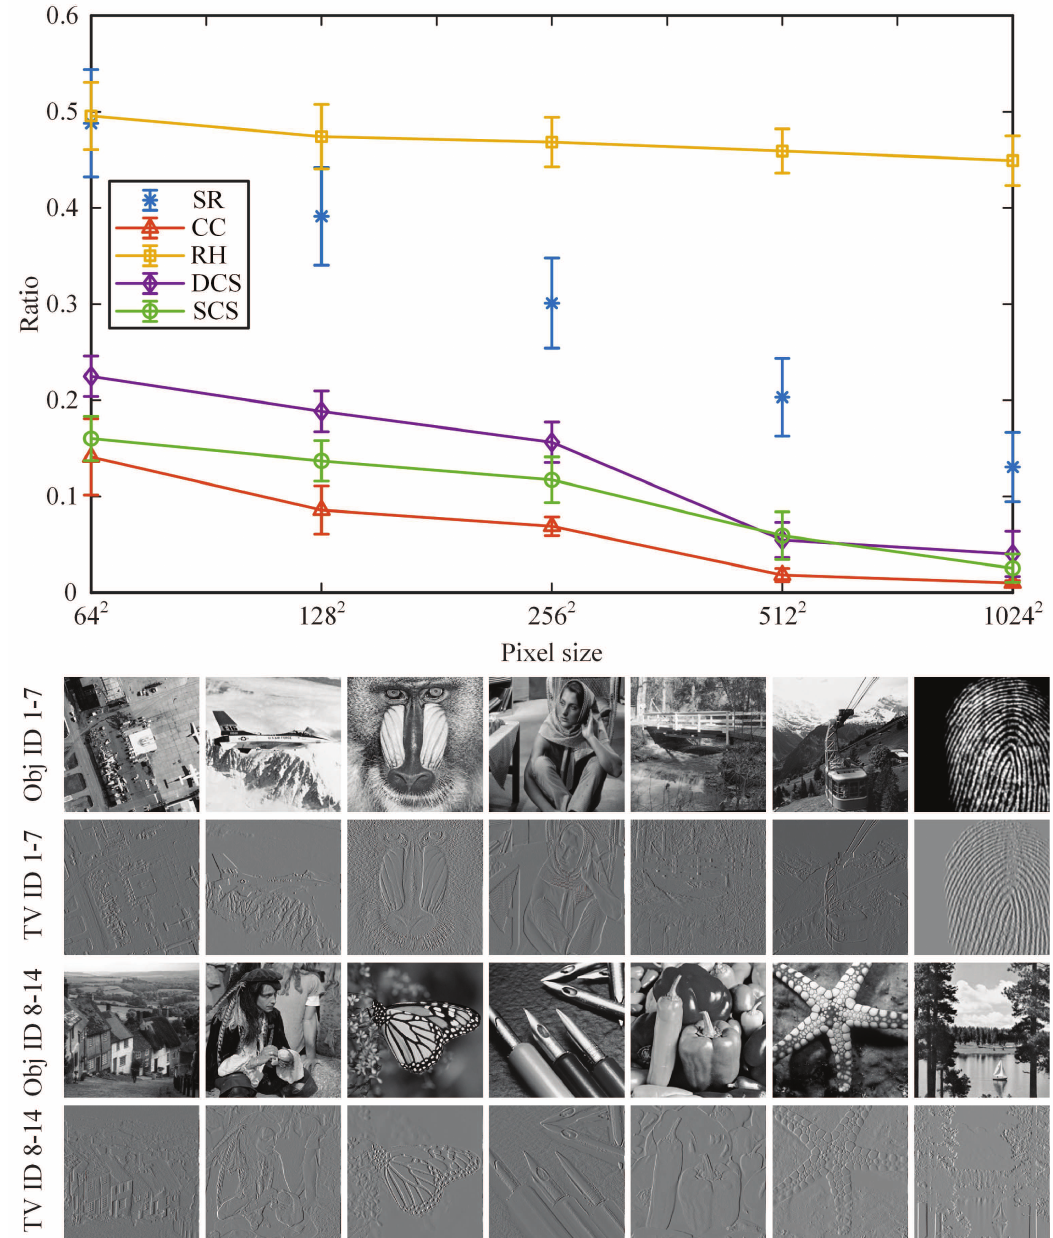
Figure 8. Sampling ratios of CC, RH, DCS, and SCS methods compared with the sparsity ratio as a function of image size, under a number of different object samples (of Obj IDs 1–14), with a PSNR around 20.334 dB (in which the detail of the object just can be resolved). We add the error bar to each point and the height of each error bar indicates the standard deviation of each point. In the bottom, 14 object samples used and their TV graphs are